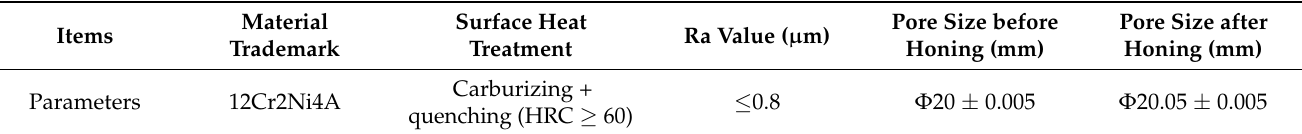
Table 1. Workpiece parameters.